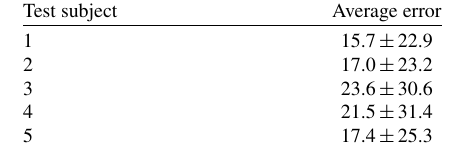
Table 5 The average error of the shoulder and elbow posi-